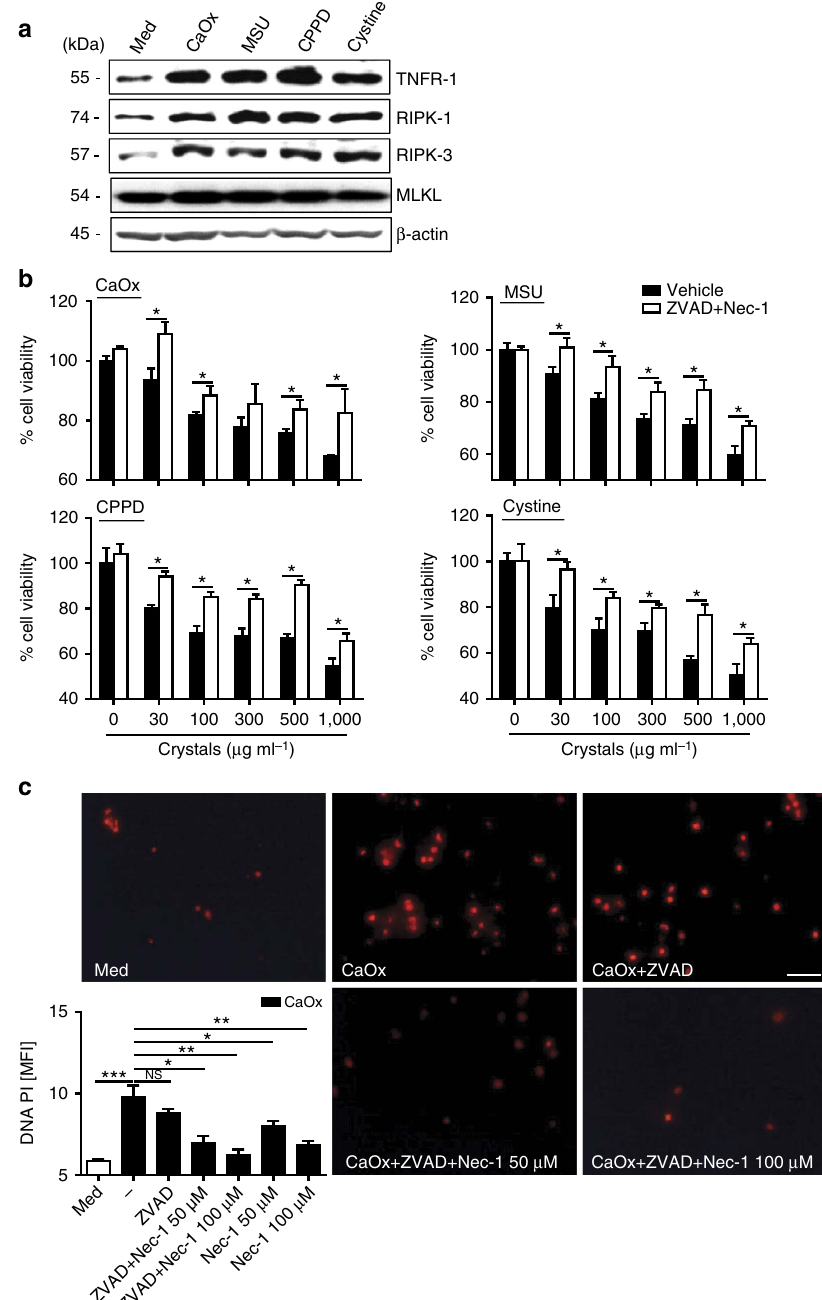
Figure 2 | Crystal cytotoxicity involves the necroptosis pathway. ( a ): Protein expression of TNFR1, RIPK1 and RIPK3 was determined by western blot from total proteins isolated 18h after stimulation of mouse tubular epithelial cells with crystals of CaOx (1,000 m gml (cid:3) 1 ), MSU (500 m gml (cid:3) 1 ), CPPD (500 m gml (cid:3) 1 ) and cystine (500 m gml (cid:3) 1 ). b -actin was used as loading control. ( b ) Mouse tubular epithelial cells were exposed to different concentrations of CaOx, MSU, CPPD or cystine crystals as indicated in the presence or absence of necrostatin (Nec)-1 (100 m M) together with the pan-caspase inhibitor ZVAD–FMK–FMK (10 m M). Cell viability was assessed by MTT assay 24h later. Data are expressed as mean cell viability ± s.e.m. of three independent experiments. Baseline viability is set as 100%. ( c ) In similar experiments necrotic tubular epithelial cells were identified via propidium iodide positivity and the results were expressed as mean fluorescent intensity on digital analysis of pictures taken from culture dishes. Representative images are shown at an original magnification of (cid:2) 200, scale bar ,40 m m. Data were analysed using Student’s t -test. * P o 0.05, ** P o 0.01 and *** P o 0.001 versus respective medium control. NS, not significant. MTT, 3-(4,5-dimethylthiazol-2-yl)-2,5-diphenyltetrazolium